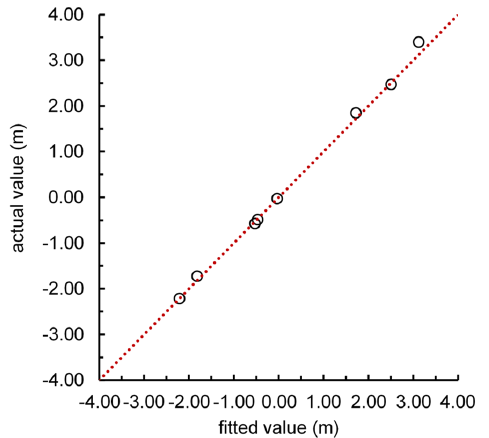
Figure 11. Comparison between the fitted and measured values of the annual change of groundwater level.